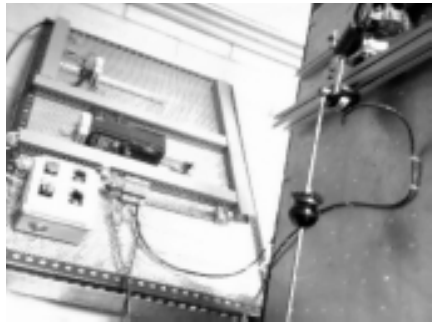
Fig. 12. Command Generator based in a simple